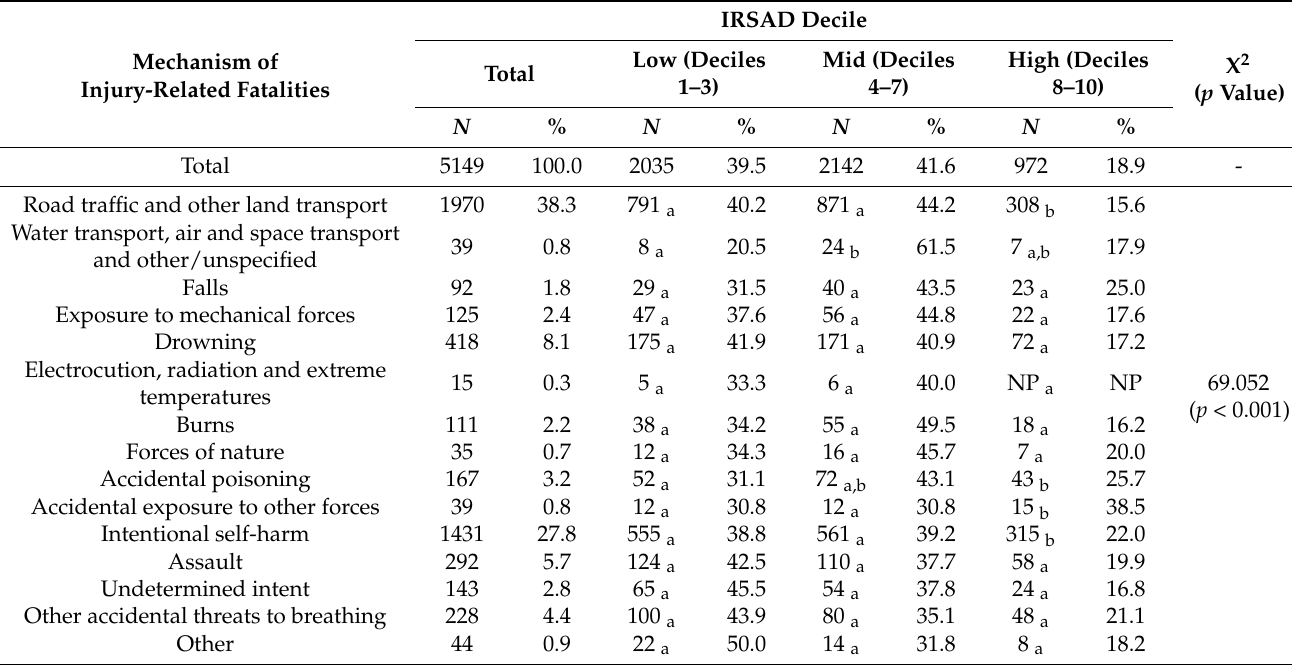
Table 8. Injury-related fatalities by age group and index of relative socio-economic advantage and disadvantage decile (IRSAD), Australia, 2007-08 to